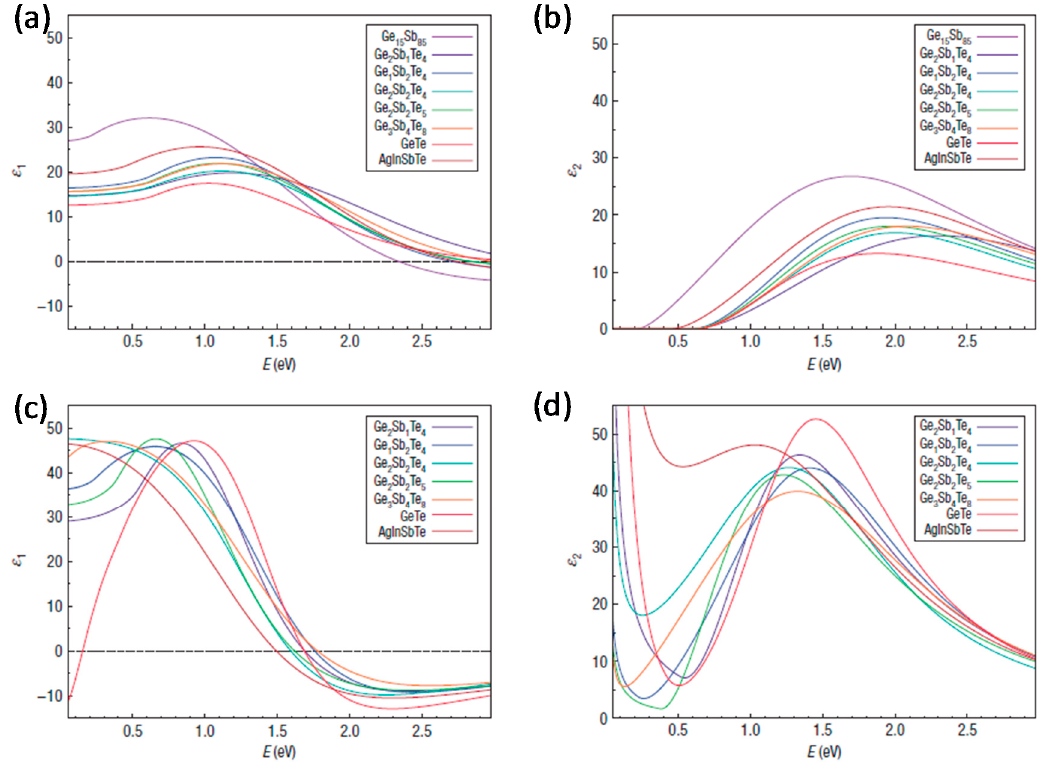
Figure 1. Dielectric function ε 1 ( ω ) and ε 2 ( ω ) as optical properties of PCMs. ( a , b ) Amorphous PCMs; ( c , d ) Crystalline PCMs incorporating Drude-type impact. Adapted from [22], with permission from © 2008 Nature Publishing Group.